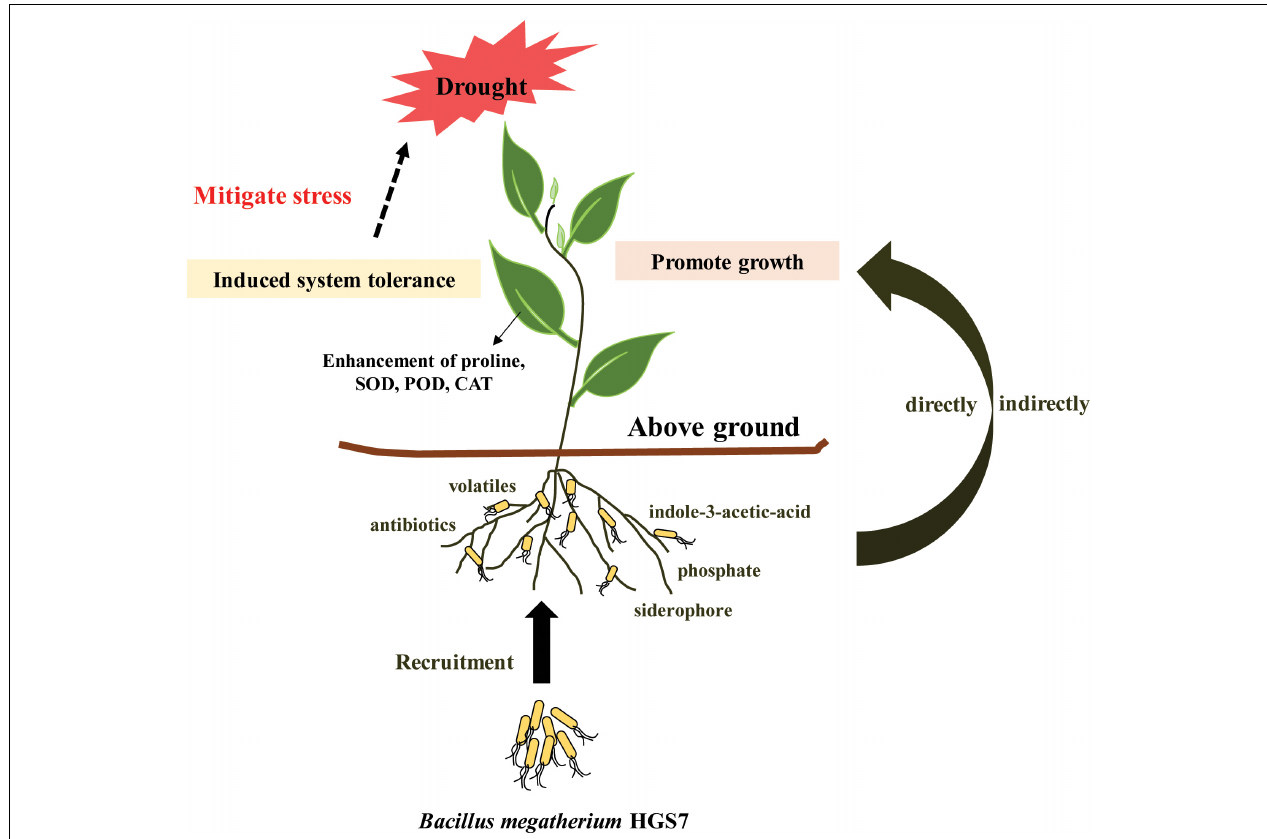
FIGURE 8 | A proposed model of B. megaterium HGS7-mediated drought tolerance mechanisms in